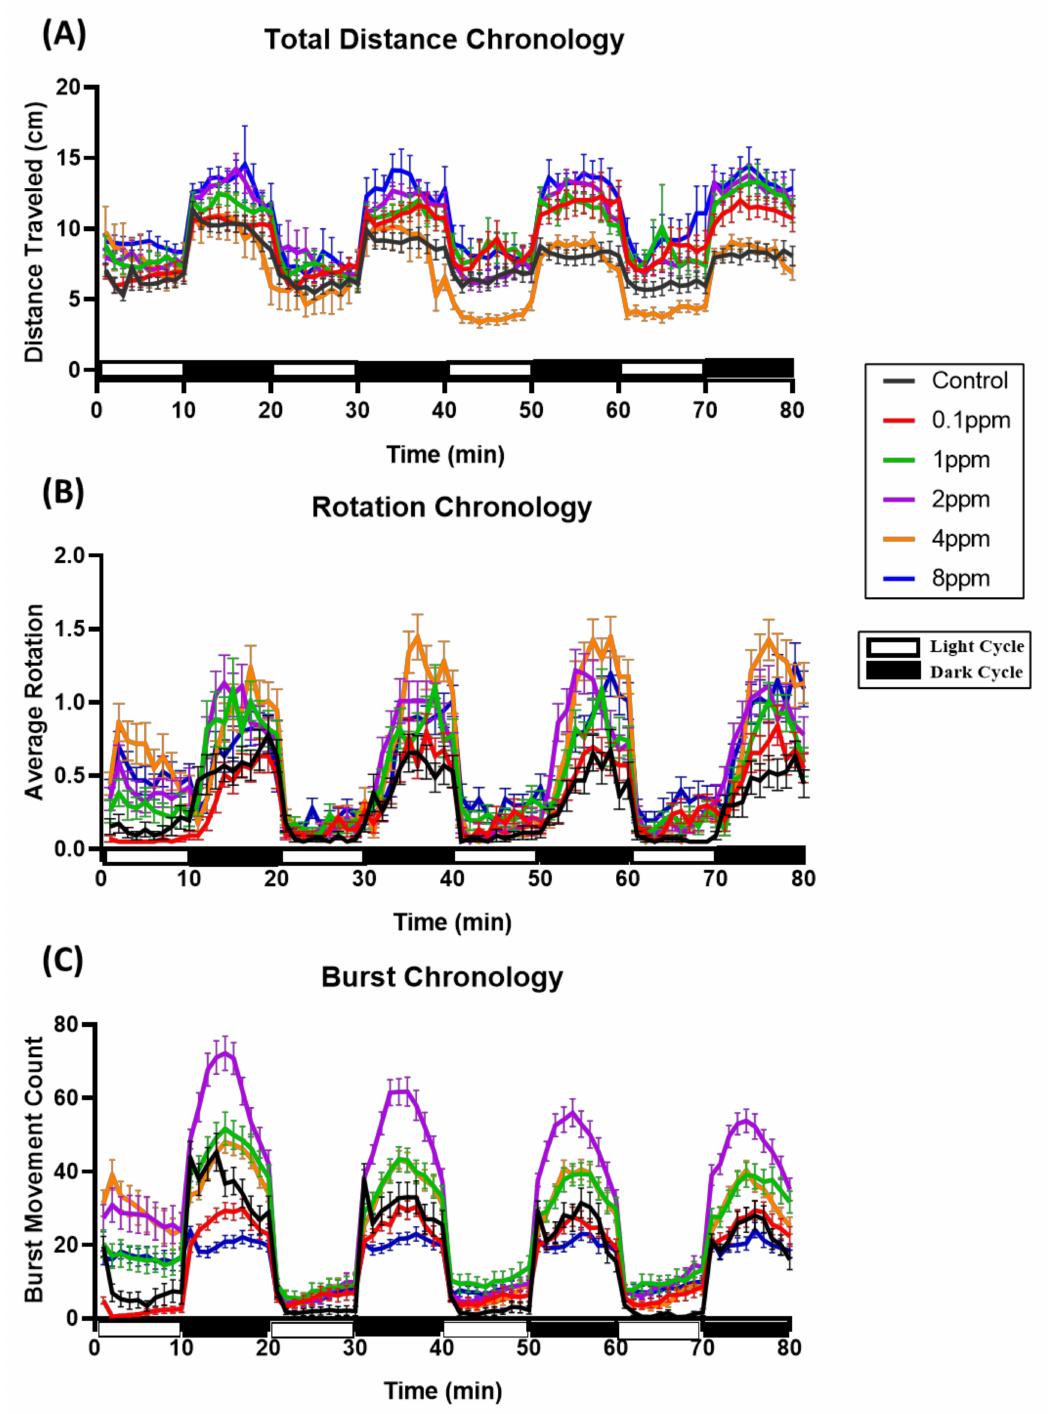
Figure A1. Comparison of locomotion behavioral pattern of zebrafish exposed to ractopamine at 0, 0.1, 1, 2, 4, and 8 ppm during both light and dark cycles. ( A ) Average total distance traveled, ( B ) average rotation, and ( C ) average burst movement count from 0 to 80 min were analyzed. The data are presented as mean with SEM ( n = 96 for all